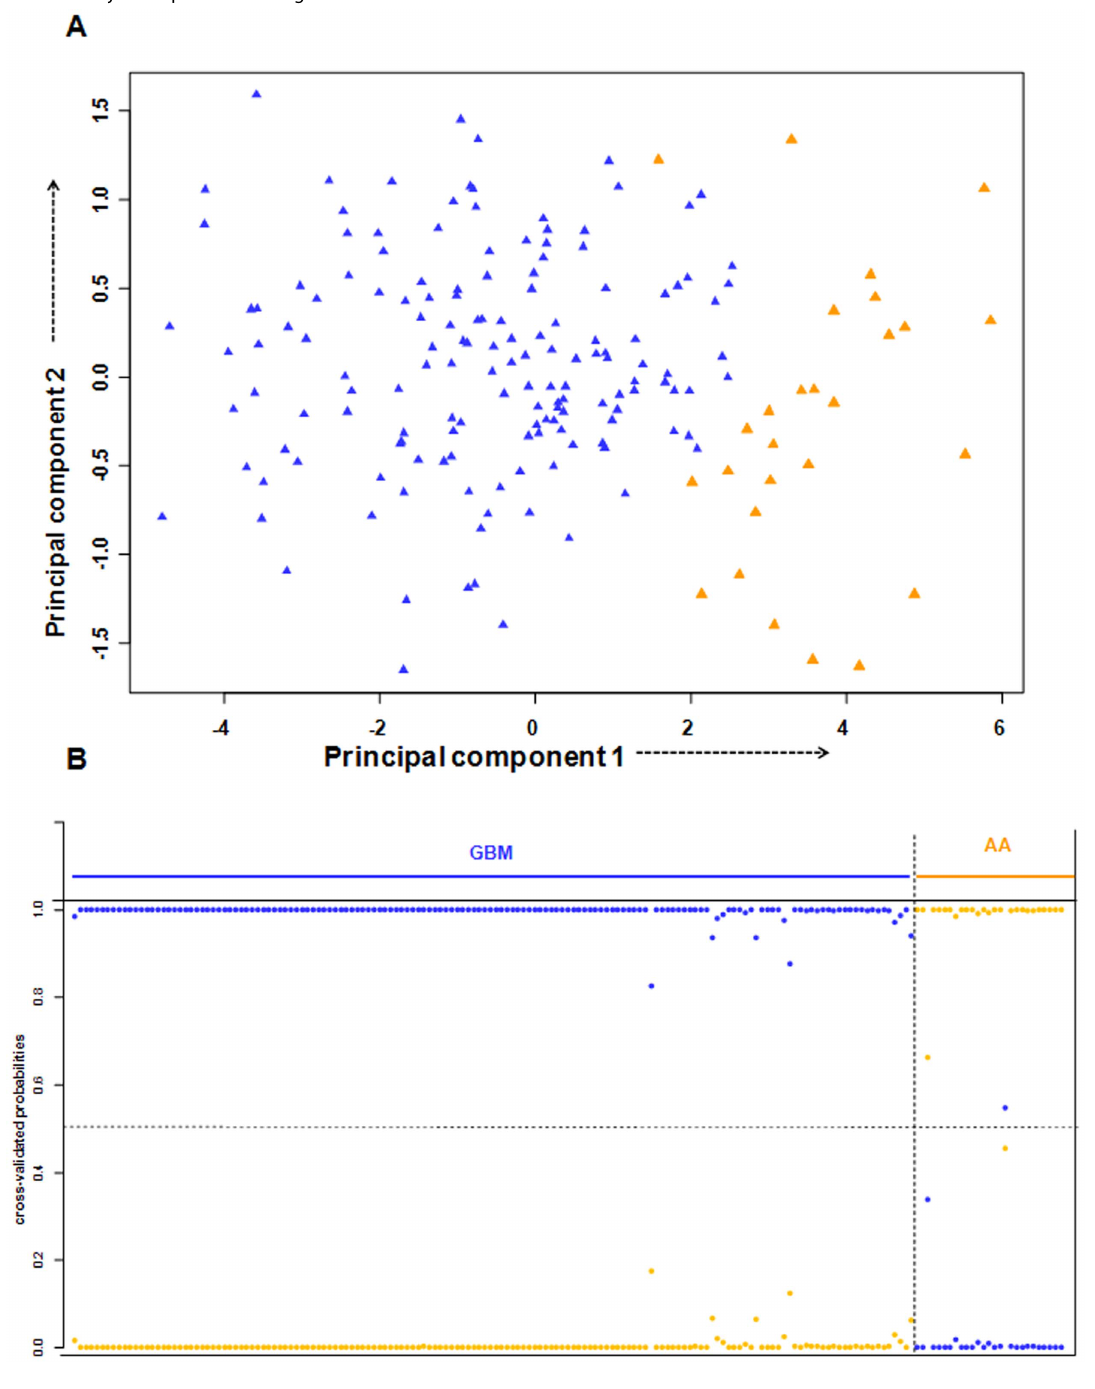
Figure 5. PCA and cross validated probabilities of AA and GBM samples of TCGA dataset. A. PCA was performed using expression values of 16- PAM identified genes between grade III glioma (n=27) and GBM (n=152) samples in TCGA dataset. A scatter plot is generated using the first two principal components for each sample. The color code of the samples is as indicated. B. The detailed probabilities of 10-fold cross-validation for the samples of TCGA dataset based on the expression values of 16 genes are shown. For each sample, its probability as grade III glioma (orange color) and GBM (blue color) are shown and it was predicted by the PAM program as either grade III glioma or GBM based on which grade’s probability is higher. The original histological grade of the samples is shown on the top.